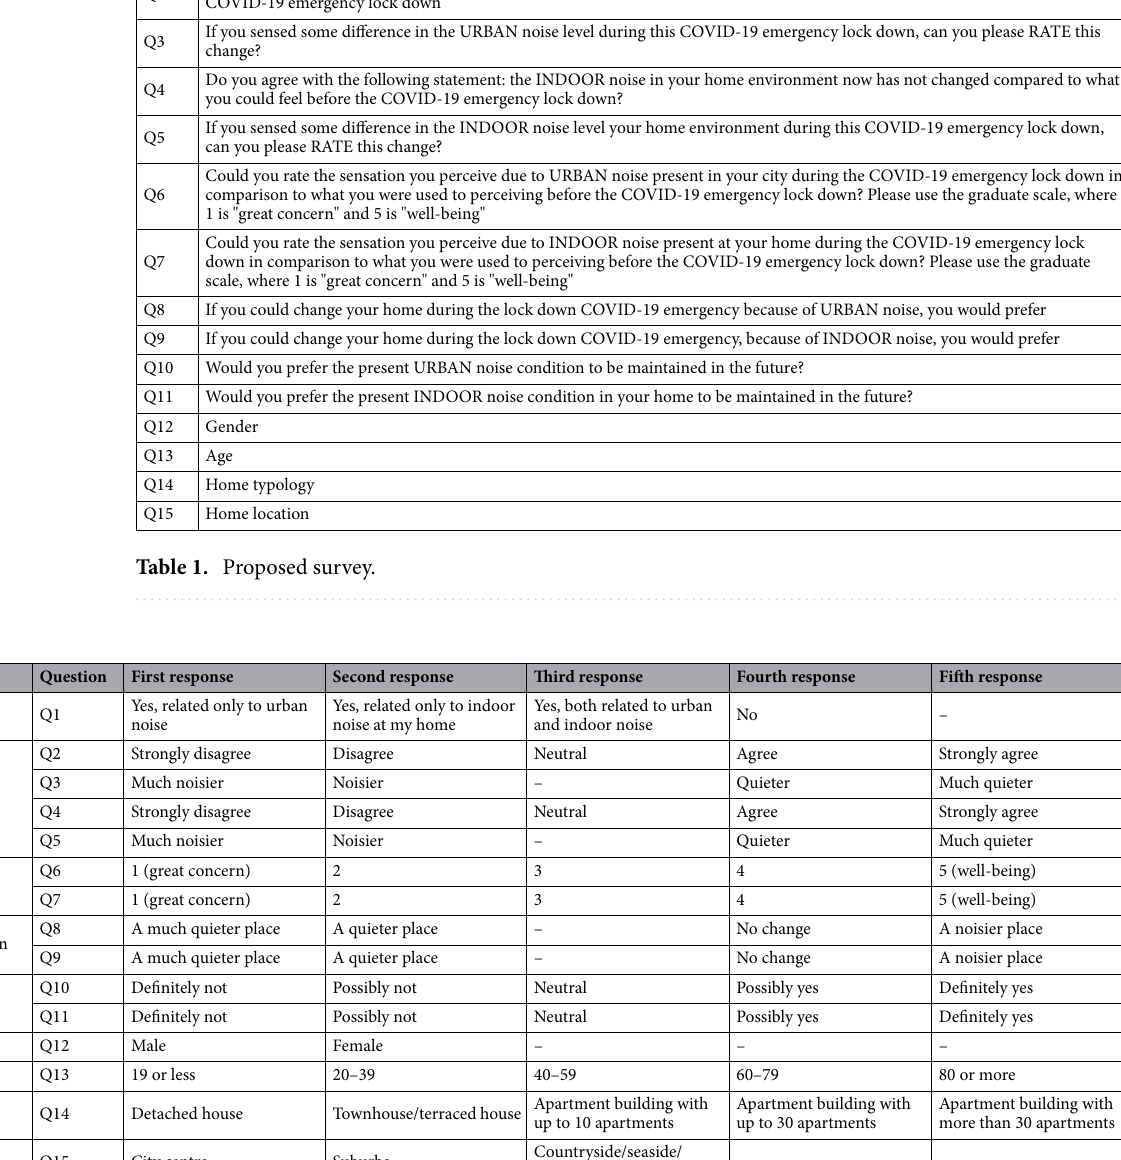
4. the general initial question Q1 was considered endogenous and the indoor questions were considered inde- pendent. CART Decision Trees is used as predictive model approach. A decision tree is useful from observations point of view about an item (represented in the lines or connections) to conclusions about the item’s target value (repre- sented in the rectangles or circles—tree “leaves”). Tree representations can manage a discrete dataset and are also named “classification trees”; in their structures, “leaves” are used to embody class labels and connection embody conjunctions of topics linking those labels. Decision trees used very often because of their clear representation of the treated topics 38 . The software “wessa.net” was used to plot results 39 . Both for Mann-Witney tests and for CART regression trees, numbers from 1 to five were associated to responses, choosing 3 as neutral answer. When a 4-points Likert’s scale was used, the 3 score was not considered.